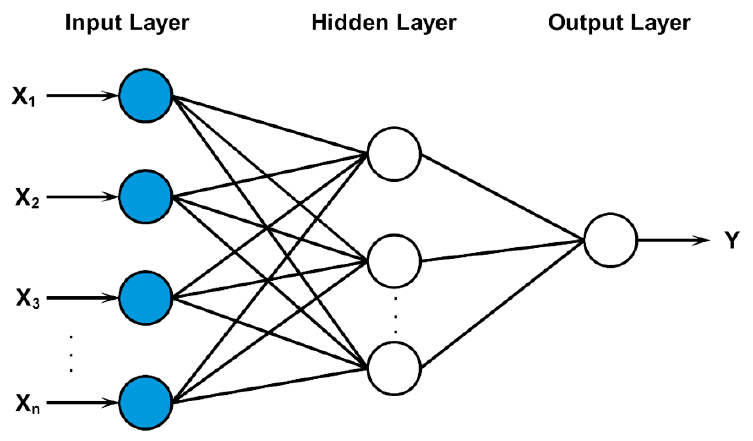
Figure 4. Architecture of an MLP neural network.